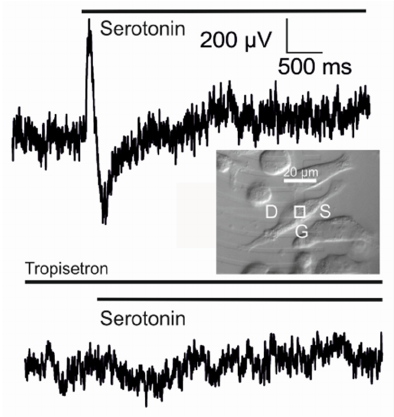
Figure 14. Transistor recording of the serotonin receptor 5-HT3A with the potassium channel Kv1.3 in HEK293 cell [35] for a low ion sensitivity of the gate oxide. The upper trace shows the apparent V δ upon application of 100 µM serotonin. The biphasic transient change of the gate voltage EOS Gapp reflects the current-induced extracellular voltage in the cell-substrate junction. The lower trace is a control experiment with the same cell in the presence of 1 µM tropisetron, a selective antagonist of the 5-HT3A receptor. The micrograph shows the position of cell and transistor (source, gate, drain).